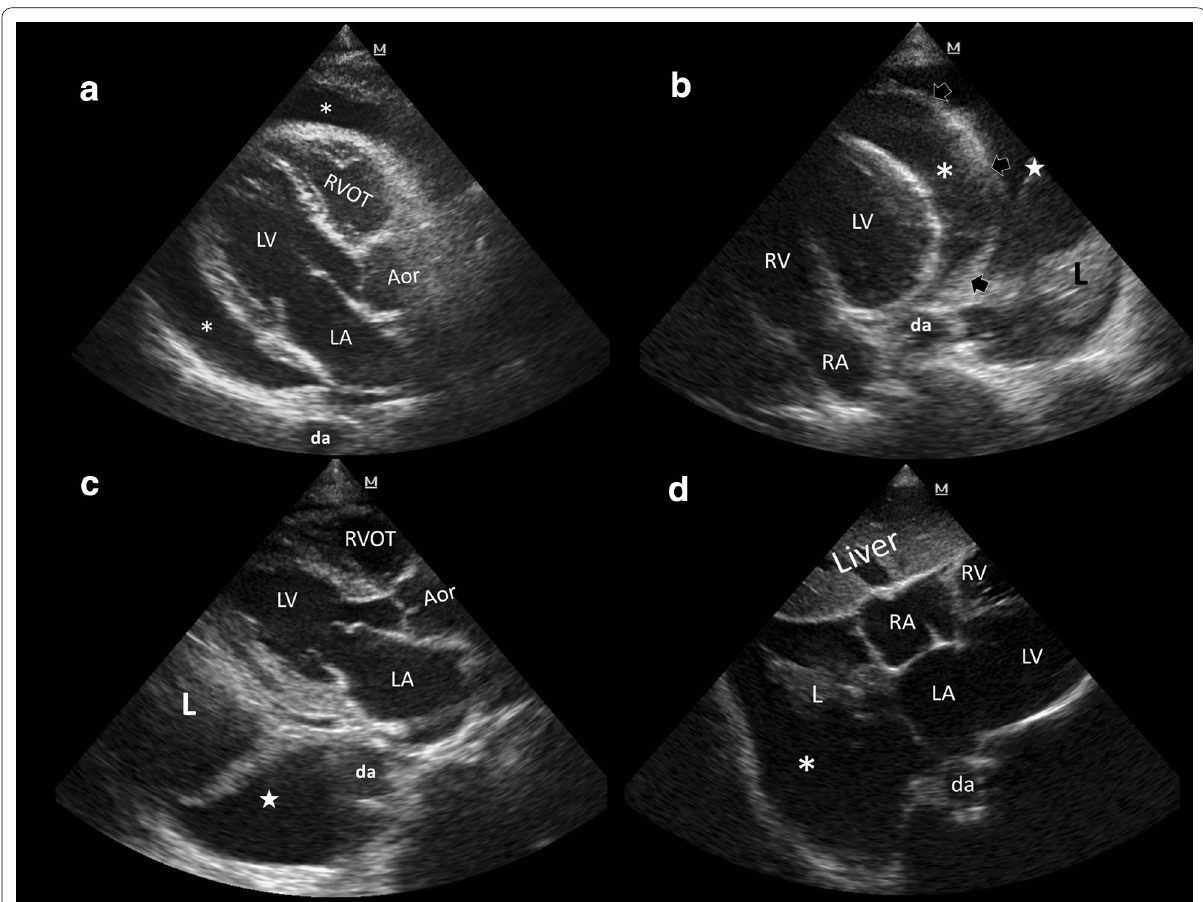
Fig. 1 Pericardial versus pleural effusion. a Parasternal long axis view. Pericardial effusion ( asterisks ) tracks anterior to the descending aorta (da); LV left ventricle, LA left atrium, RVOT right ventricle outflow tract, Aor aortic root. b Apical 4-chamber view. Pericardial effusion ( asterisk ) tracks anterior to the descending aorta (da); pleural effusion ( white star ) tracks posterior and lateral to the da. Arrows pericardial delineation, L lung consolidation, LV left ventricle, RV right ventricle, RA right atrium. c Pleural effusion ( white star ) tracks posterior and lateral to the da; L lung consolidation, LV left ventricle, LA left atrium, RVOT right ventricle outflow tract, Aor aortic root. d Right pleural effusion ( asterisk ) extending into the bare area of the liver, besides the heart in subcostal 4-chamber view; L lung consolidation, RA right atrium, RV right ventricle, LA left atrium, LV left ventricle, da descend- ing